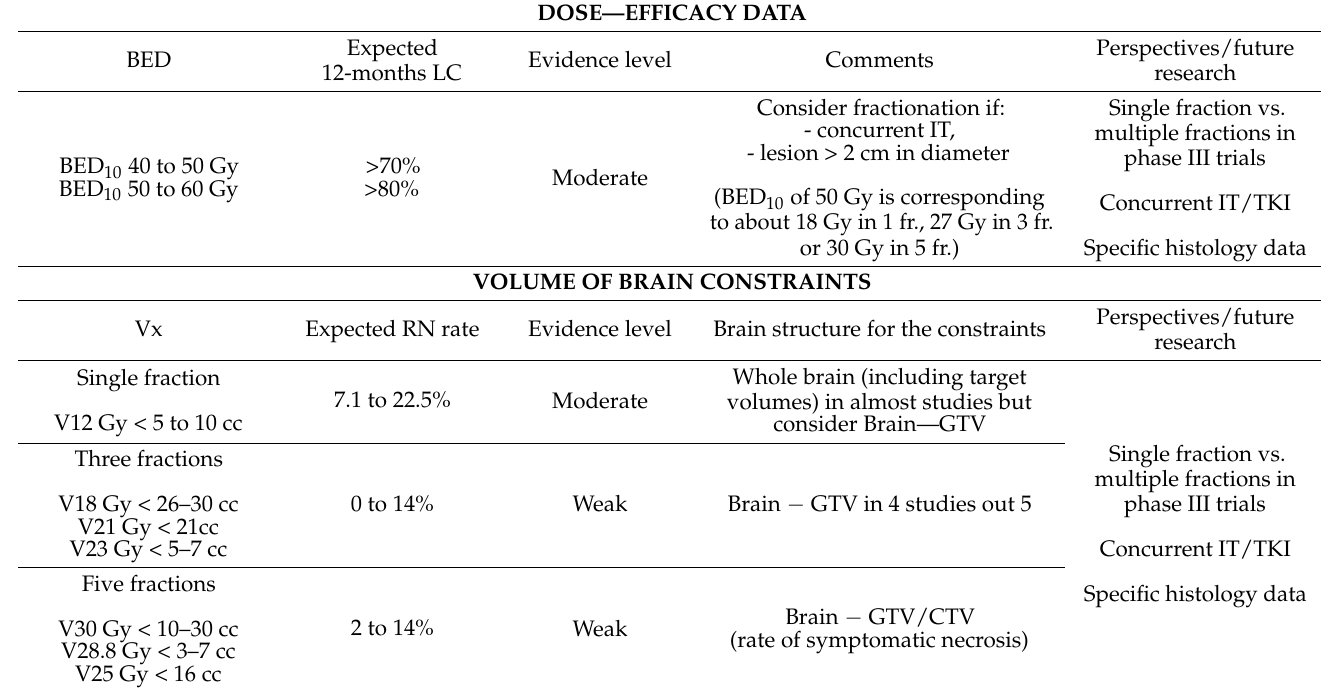
Table 3. Summary of dose-efficacy and dose-toxicity data in brain metastasis SRT